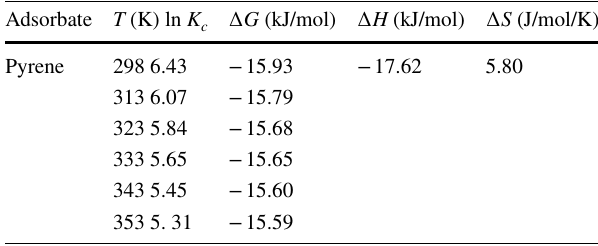
Table 7 Thermodynamic parameters of pyrene adsorption over